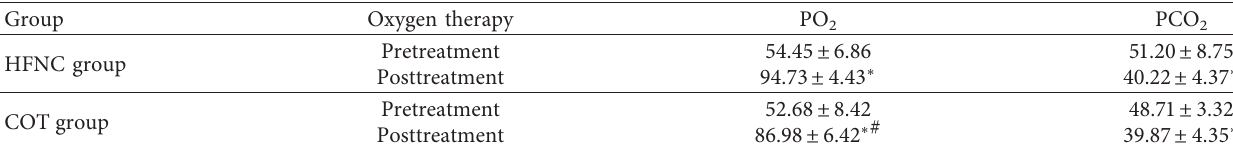
Table 3: Effects of HFNC and COT on PO